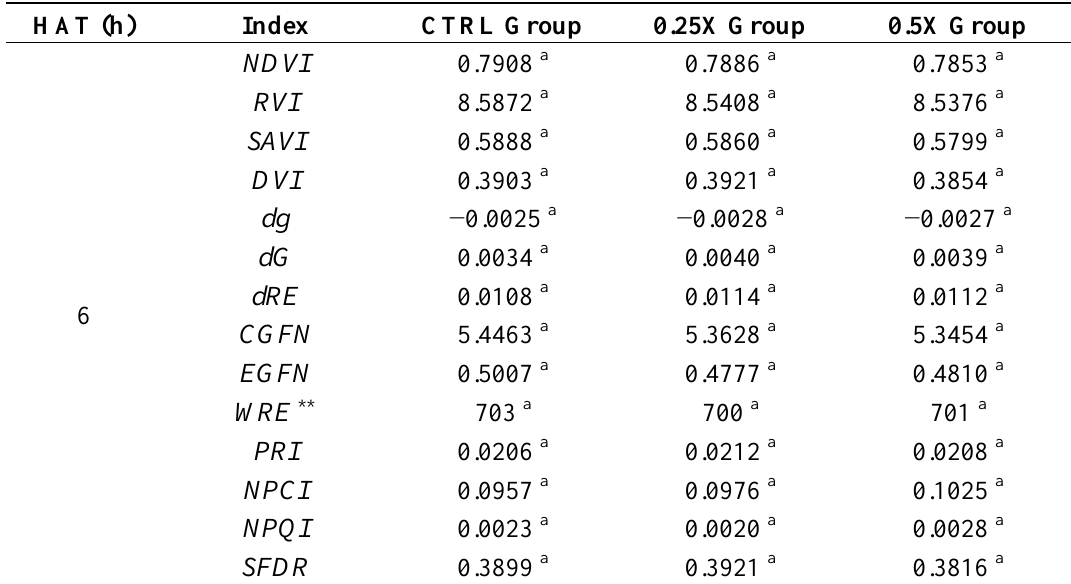
Table 5. Calculated spectral indices of the three groups of cotton leaves at 6, 24, 48, 72 HAT. Each value is a mean of six leaves. The separation results are based on the Duncan’s multiple range test.